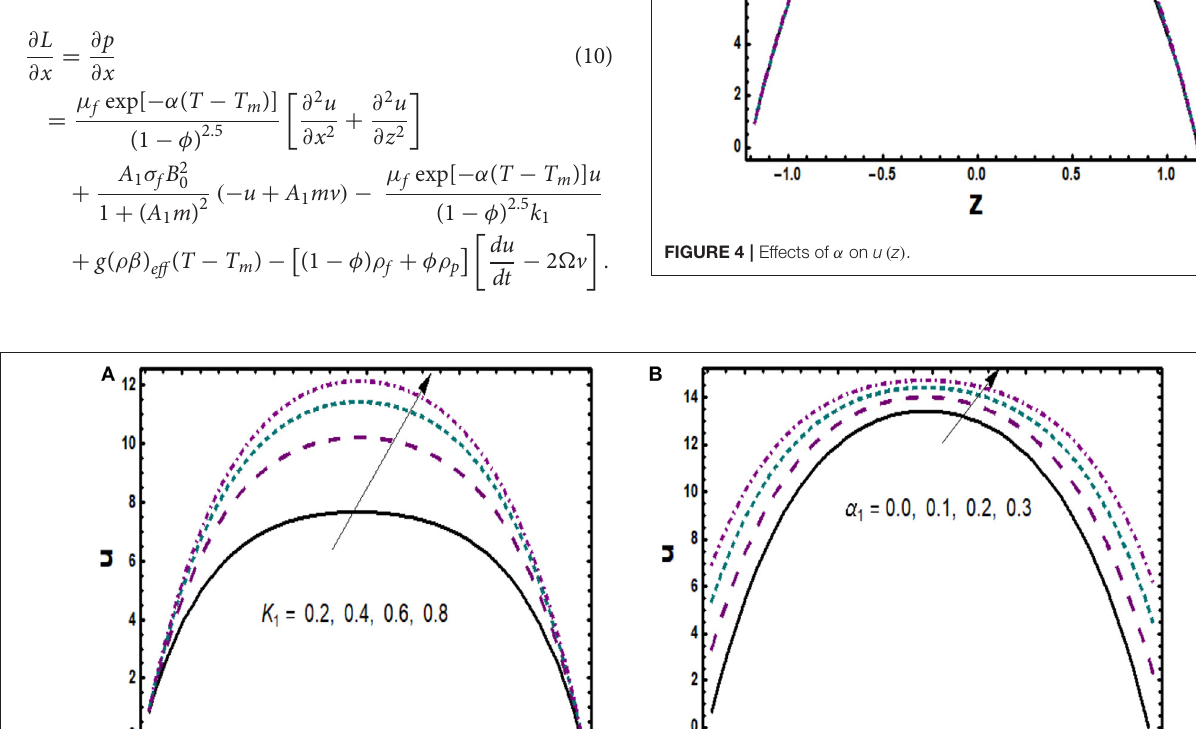
Frontiers in Physics |